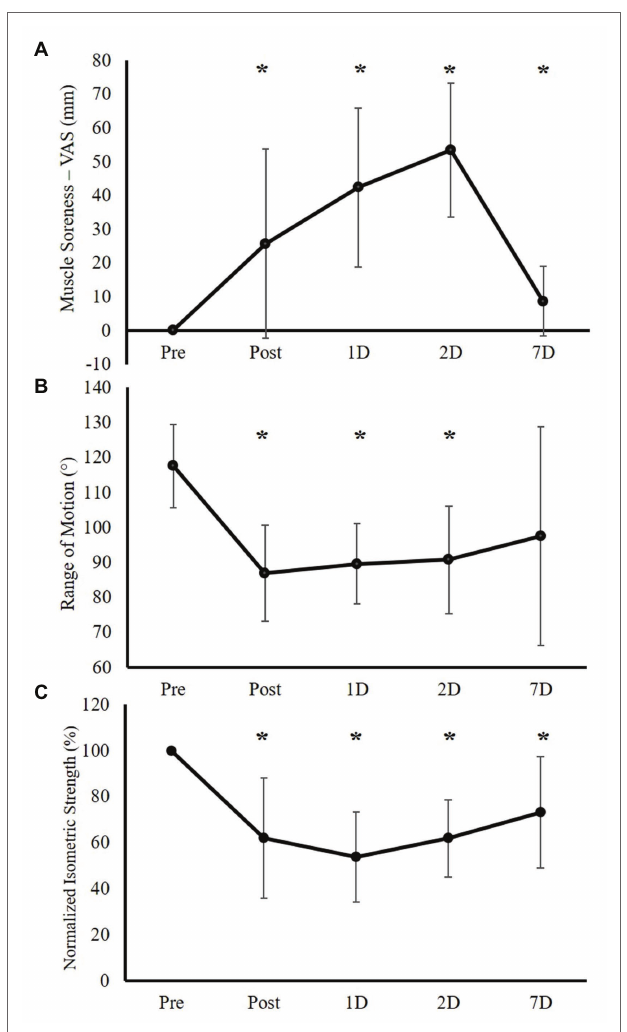
FIGURE 2 | Elbow flexor muscle damage indirect markers’ responses immediately following (Post), 1 day after (1D), 2 days after (2D), and 7 days after (7D) the elbow flexion (EF) eccentric exercise (ECC) intervention (Experimental Group only, n = 15). (A) Muscle soreness responses as measured by visual analog scale (VAS). (B) Range of motion responses. (C) Maximal isometric strength responses (normalized as the percentage of the Pre-testing isometric strength). *Significant difference between Pre-testing